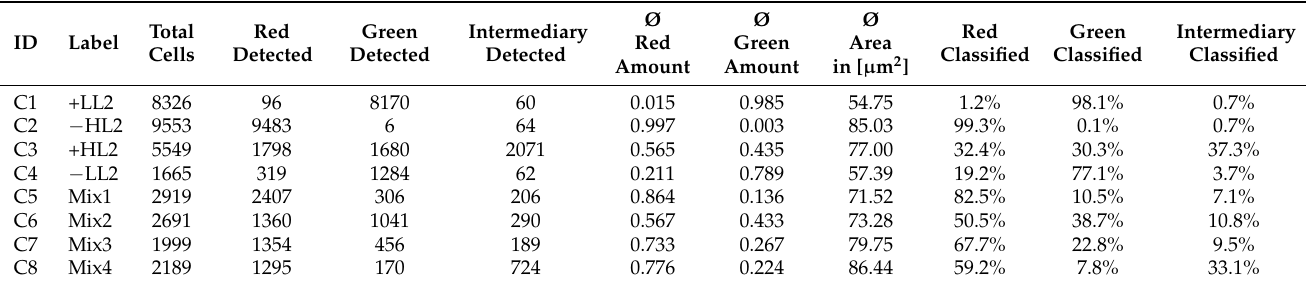
Table 2. Conclusions of realized MIFC